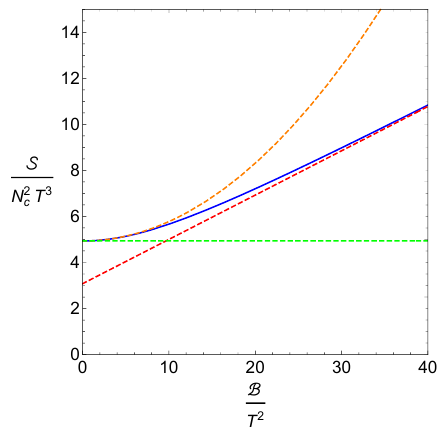
Figure 3 . The dimensionless entropy density s = S /T 3 (solid blue line), divided by N 2 function of b = B /T 2 , compared with the analytical solution at small b (orange dashed line) and large b (red dashed line). The analytical solutions at small b and large b , shown in equations (4.4) and (4.5), were obtained in appendices A and B respectively. The green dashed line depicts the Stefan-Boltzmann limit at b = 0